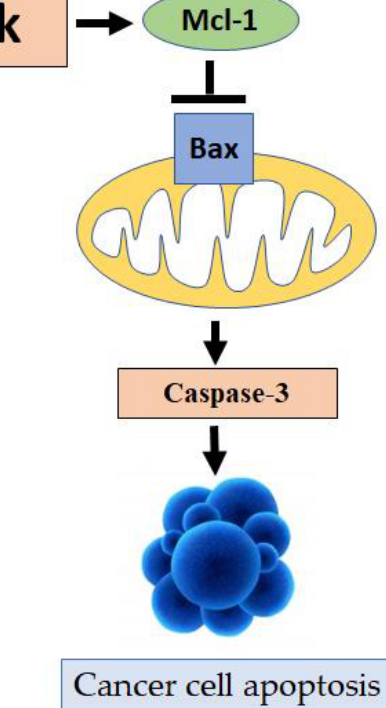
Figure 13. Buxifoliadine E inhibits cell proliferation and induces apoptosis through Erk